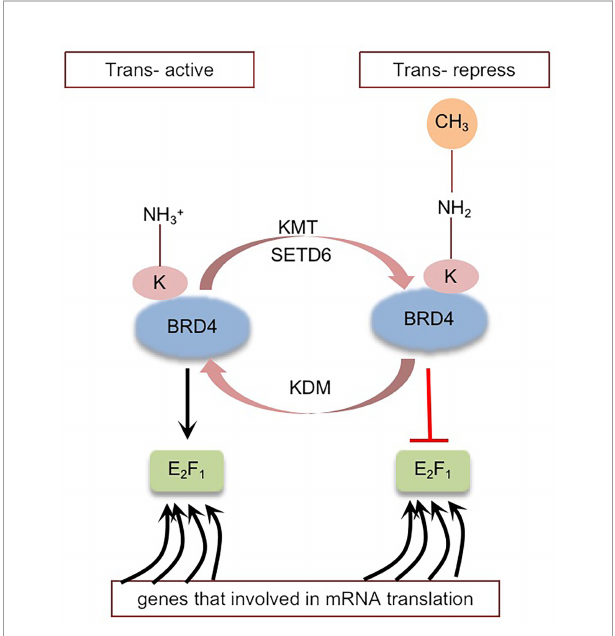
FIGURE 4 | Schematic representation of BRD4 methylation: BRD4 methylation mediated by KMT (SETD6) inhibits the selective recruitment of transcription factor E2F1 to translation related target genes, resulting in global translation inhibition. Black arrows indicate positive effects. Red perpendicular bars indicate negative effects. Tans-active, Translation active; Trans-repress, Translation